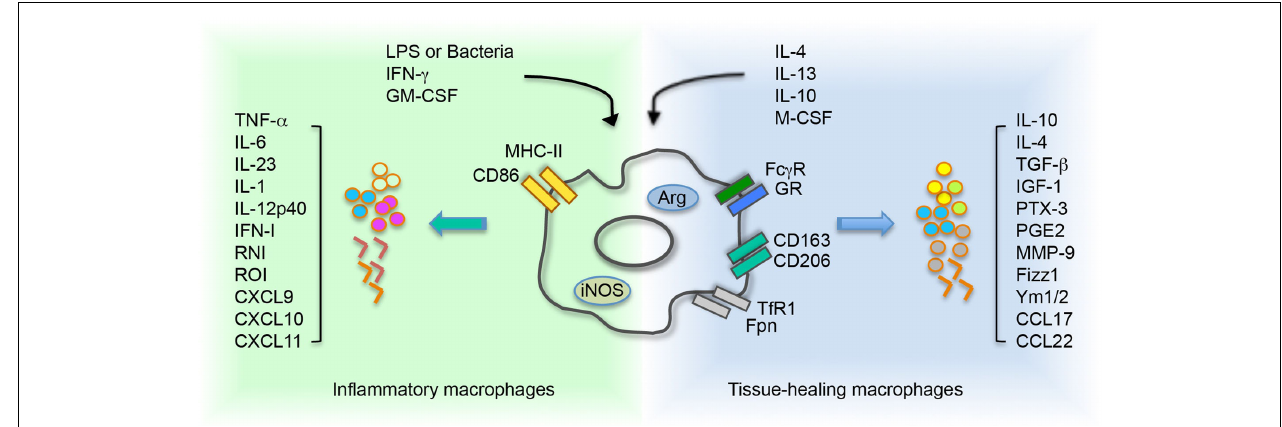
macrophage-colony stimulating factor; M-CSF, macrophage-colony stimulating factor; MHCII, major histocompatibility complex class II; GR, galactose receptor; CD163, haptoglobin–hemoglobin complex receptor; CD206, mannose receptor;TfR1, transferrin receptor 1; Fpn, ferroportin;TGF- β , transforming growth factor β ; IGF1, insulin like growth factor 1; PTX-3, pentraxin 3; PGE2, prostaglandin E2; MMP-9, matrix metalloproteinase 9; Fizz, resistin like molecule;Ym1/2, chitinase like protein 1/2;TNF- α , tumor necrosis factor α ; IFN, interferon type I; RNI, reactive nitrogen intermediate; ROI, reactive oxygen